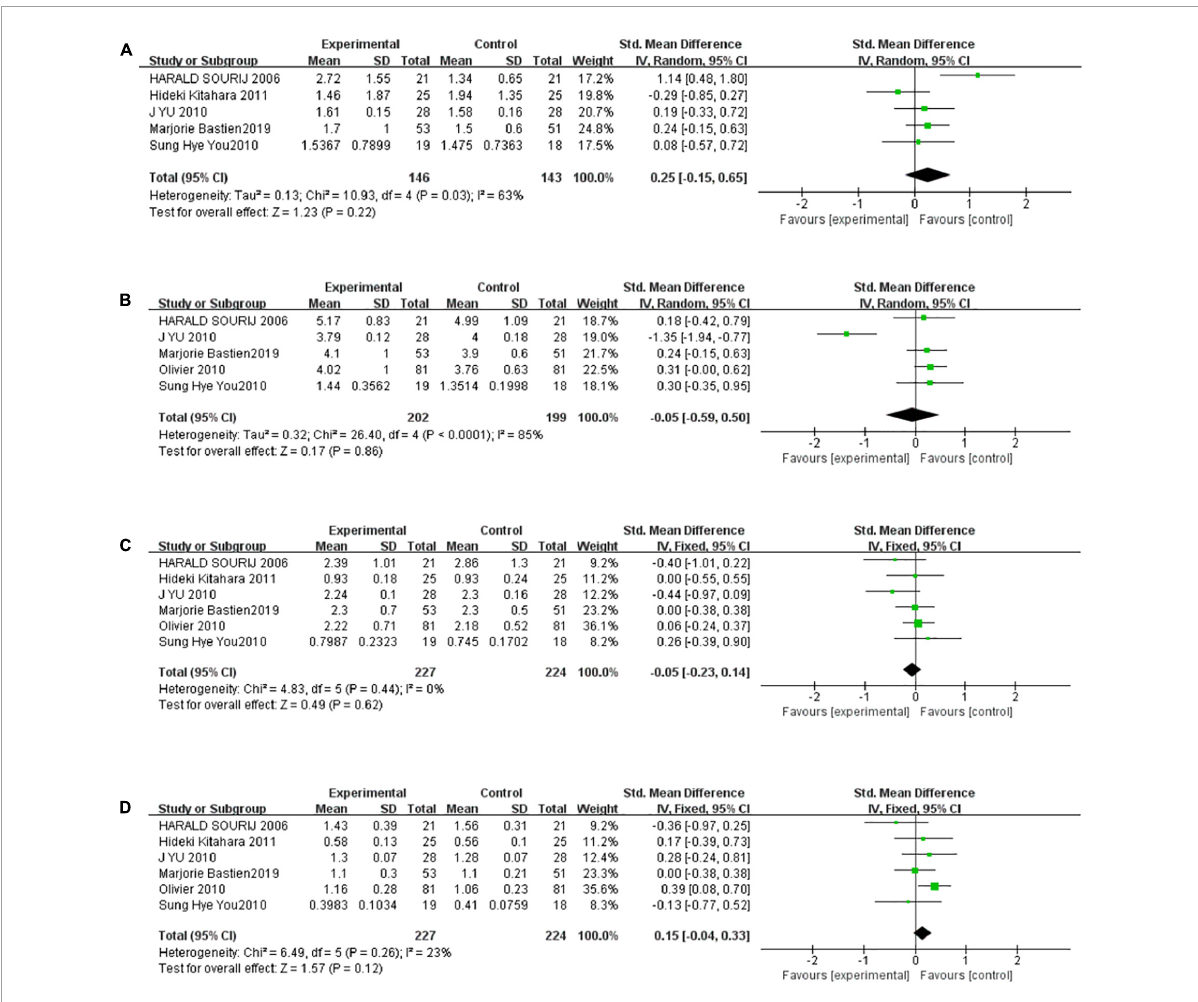
FIGURE5 The effect of the TZDs on the serum lipid profile was unstable. (A) Effect of the TZDs on TG (mmol/L). (B) Effect of the TZDs on TC (mmol/L). (C) Effect of the TZDs on LDL-C (mmol/L). (D) Effect of the TZDs on HDL-C (mmol/L).